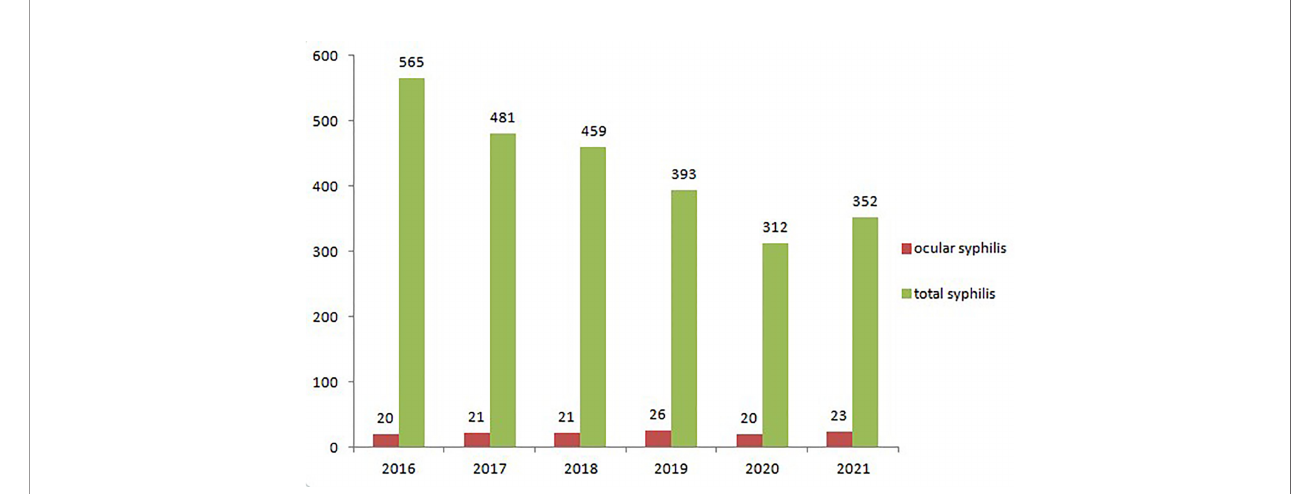
FIGURE 1 | Annual numbers of ocular syphilis and total syphilis